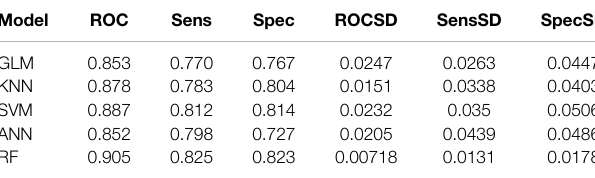
TABLE 1 | Prediction performance of models for up-regulation pairs using the 5-fold cross validation on the training dataset.